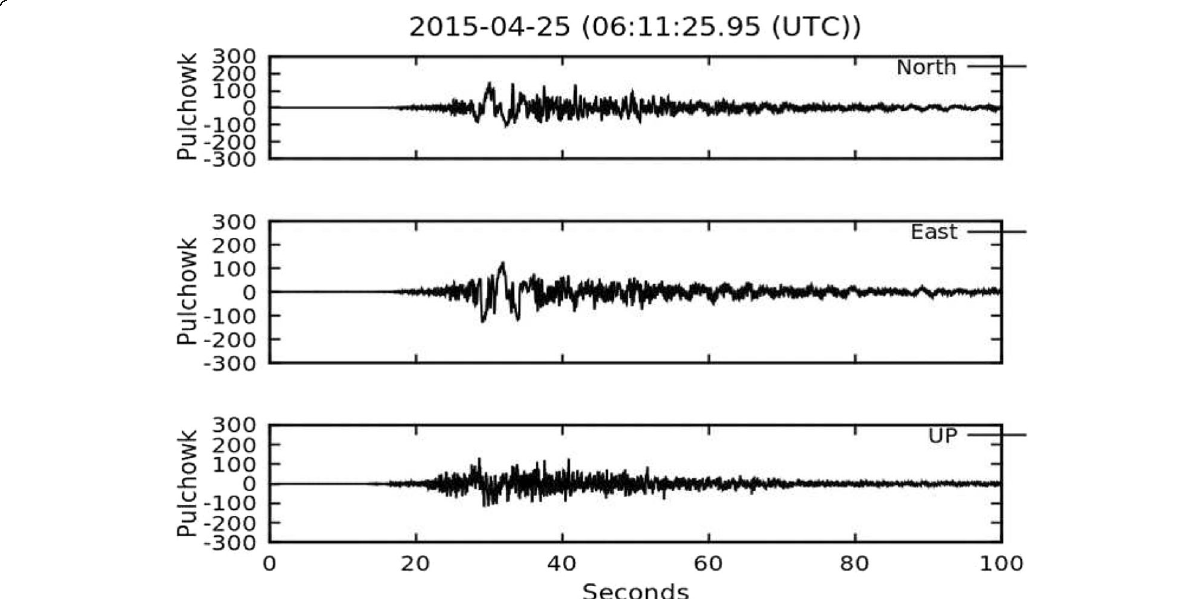
Fig. 7 Ground acceleration waveform recorded at station PTN. The x-axis and y-axis represents time scale in seconds and ground acceleration in cm/s 2